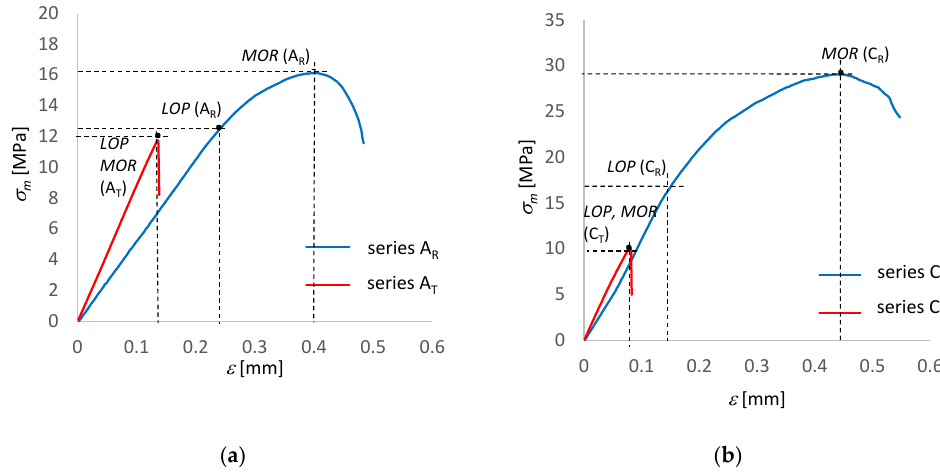
Figure 4. Bending σ – ε curves for fibre-cement boards of: ( a ) series A, ( b ) series C. Table 2. Tested FCB of series A and C and their basic specifications.